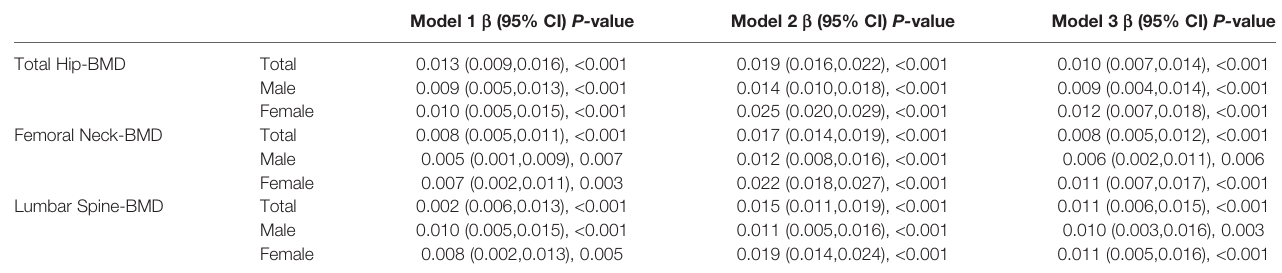
TABLE 4 | Associations between glycohemoglobin and BMD values.